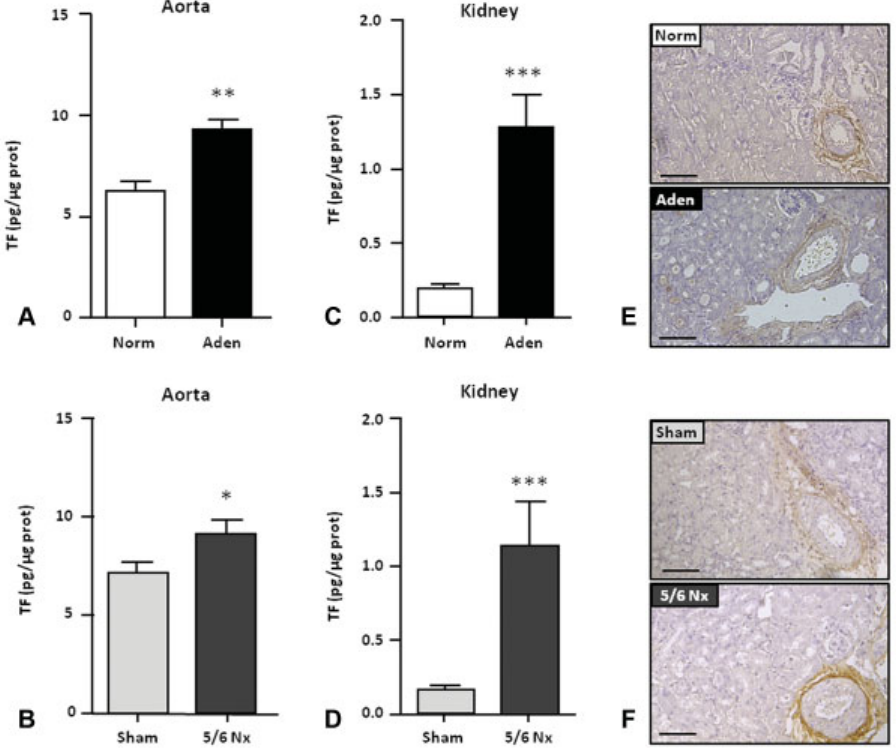
Fig.4 TF proteinexpression is increased inmice with CKD. ELISA of TF wasperformed withextractof aorta ( A, C ) and kidneys ( B, D ) isolated from mice fed with adenine 0.25% (Aden) or with Norm and from sham- or 5/6Nx- operated mice. ( E, F ) Representative immunohistochemical staining of TF in kidney. Aden, adenine diet; CKD, chronic kidney disease; ELISA, enzyme-linked immunosorbent assay; Norm, normal diet; Nx, nephrectomy; SEM, standard error of the mean; TF, tissue factor. Data are expressed as mean (cid:3) SEM, n ¼ 6 – 8/group. (cid:4) p < 0.05; (cid:4)(cid:4) p < 0.01; (cid:4)(cid:4)(cid:4) p < 0.001. Scale bars ¼ 100 μ m.